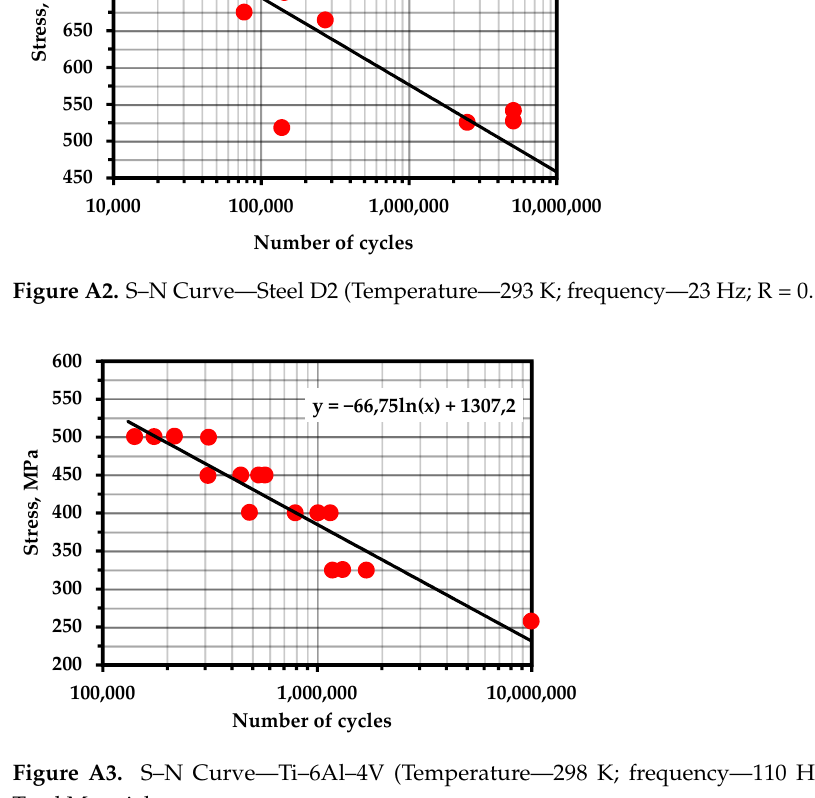
Figure A4. S–N Curve—Ti-15V-3.0Cr-3.0Al-3.0Sn (Temperature—298 К ; frequency—20 Hz). Source—Base Total material. Figure A5. S–N Curve—Steel AISI 304SS (Temperature—293; frequency—50 Hz; R = 1.5) [100].